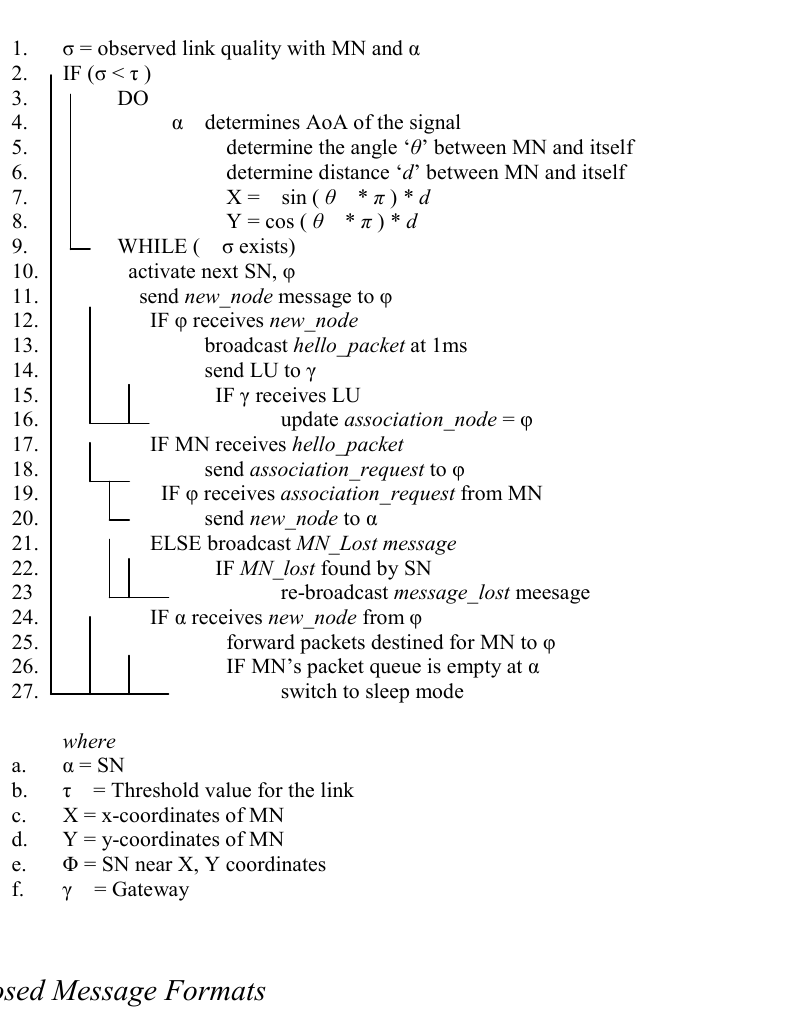
Figure 5. The algorithm for the handoff support. Algorithm for Handover of a Mobile Node using LoWMob